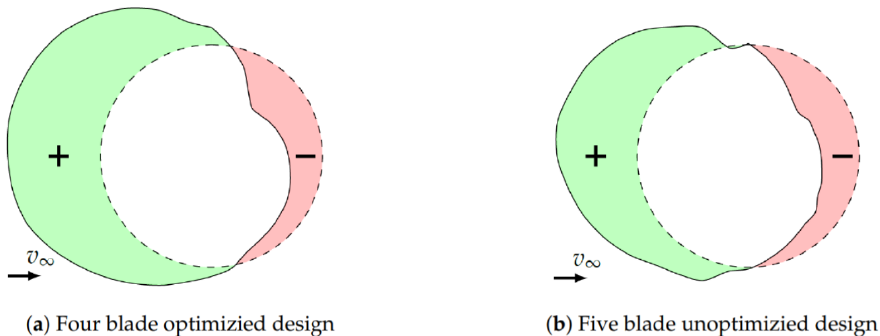
Figure 30. Qualitative torque distribution around the circumference. The optimized blade profile leads to an increased torque generation windward while keeping the losses leeward roughly the